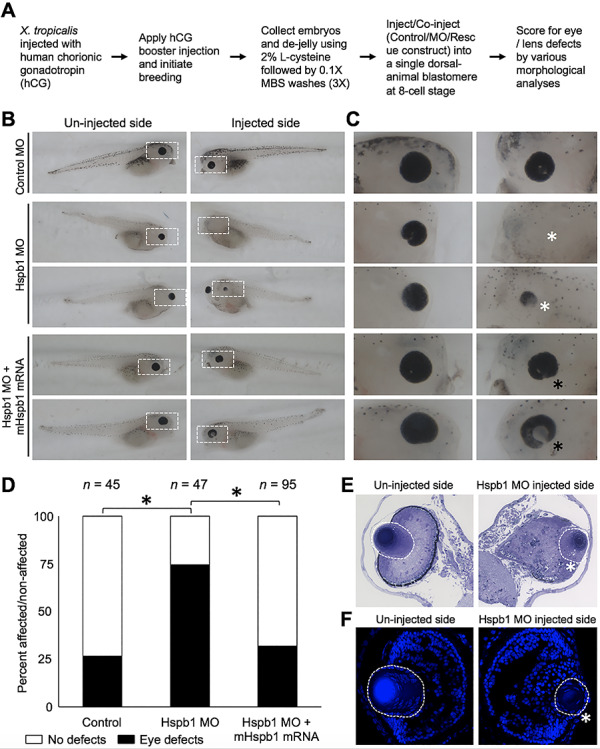

Hspb1 knockdown in X. tropicalis causes eye and lens defects. (A) Flowchart of X. tropicalis assay and phenotypic scoring. (B) Representative images of un-injected and injected side of X. tropicalis embryos injected with either control MO, Hspb1 MO or Hspb1 MO together with mouse Hspb1 mRNA (mHspb1). (C) Zoom-in images of white-dotted area in (B). (D) Chart showing the distribution of ocular defects in X. tropicalis embryos injected with either control MO, Hspb1 MO or Hspb1 MO together with mHSPB1 mRNA. The number of embryos for the different conditions is indicated on top. Black asterisk represents significant differences in the observed number of eye defects between the different conditions. For the control MO versus Hspb1 MO comparison, the P-value is 4.54 × 10−6, and for the Hspb1 MO versus Hspb1 MO + mHspb1 mRNA comparison, the P-value is 1.38 × 10−6. The control MO versus Hspb1 MO + mHSpb1 mRNA comparison is not significant (P-value = 0.55). (E) Histology analysis-based images and (F) DAPI-stained images of sections of un-injected and Hspb1 MO injected X. tropicalis embryos. White asterisk represents small eye/lens defects in Hspb1 MO-injected side of embryos. Black asterisks in (C), (E) and (F) represent rescue of eye defects in Hspb1 MO + mHspb1 mRNA-injected side of embryos. In (E) and (F), the lens is indicated by a white-dotted area.